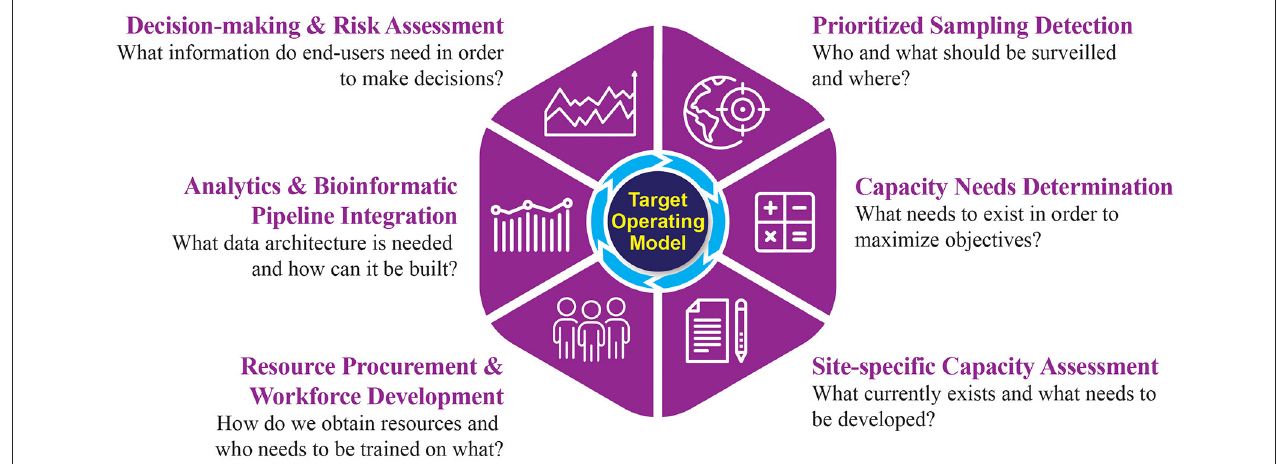
FIGURE 2 | A target operating model for the implementation of genomics-driven surveillance